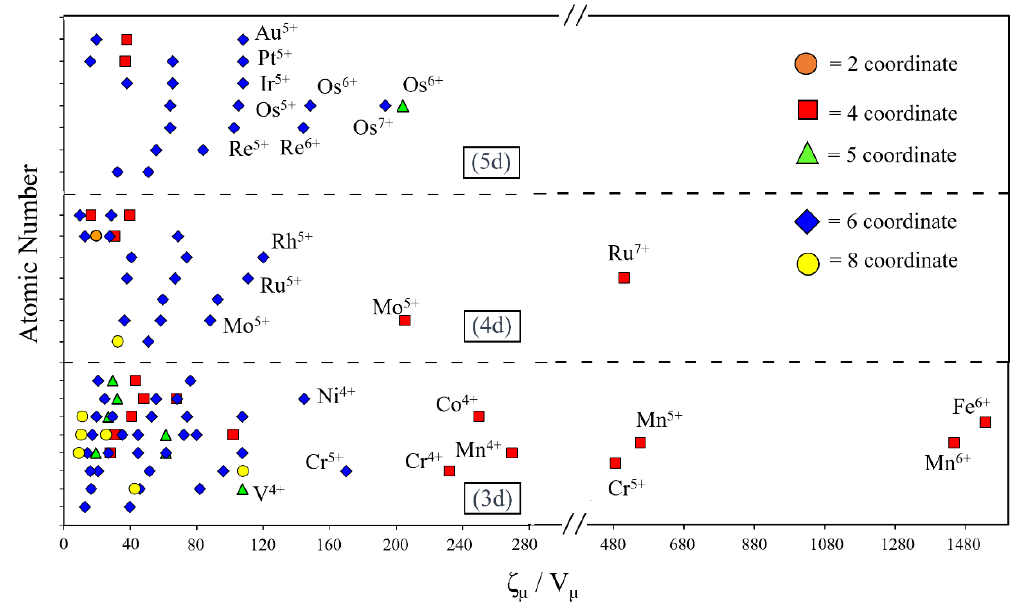
Figure 24. Plots of ζ µ / V µ versus the atomic number for the 3d, 4d and 5d TM cations. The coordination numbers of the cations are defined by the legends in the inset.